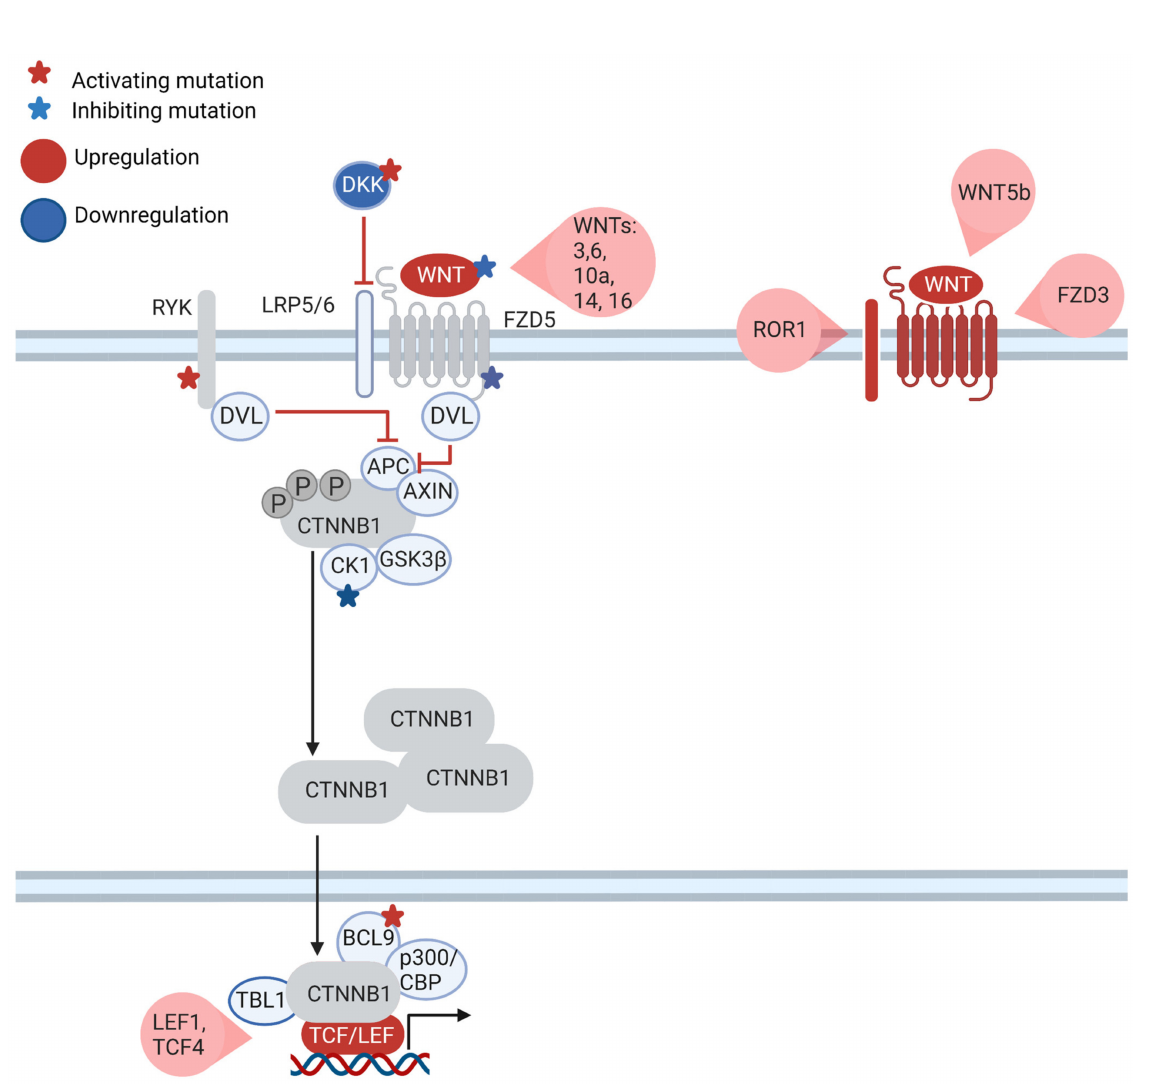
Figure 3. WNT pathway genes are mutated and dysregulated in CLL. Several WNT pathway genes are dysregulated in CLL. CLL cells often overexpress canonical WNT ligands and transcriptional components of canonical branch: LEF1 and TCF4. Pathway inhibitors such as DKK1 and 2 are epigenetically silenced. In non-canonical branch, receptors (FZD 3 , ROR1) and ligands (WNT5b) are overexpressed. Mutations of WNT pathway genes can lead to activation (DKK, BCL9 and RYK) or inhibition (FZD 5 , CK1) of β -catenin